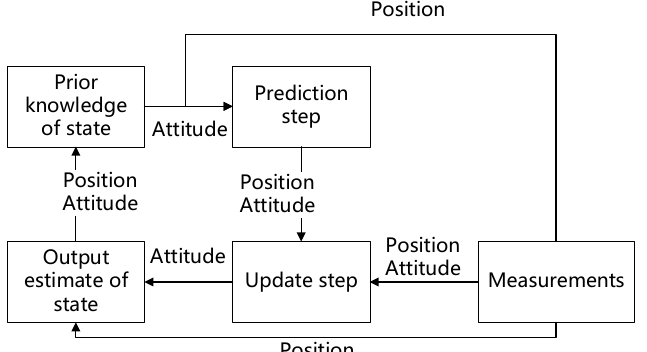
Figure 3. Diagram of the EKF algorithm applied in this research. The position measurement from the RTK GPS is directly used as the output of the filter process and the input of the next prediction